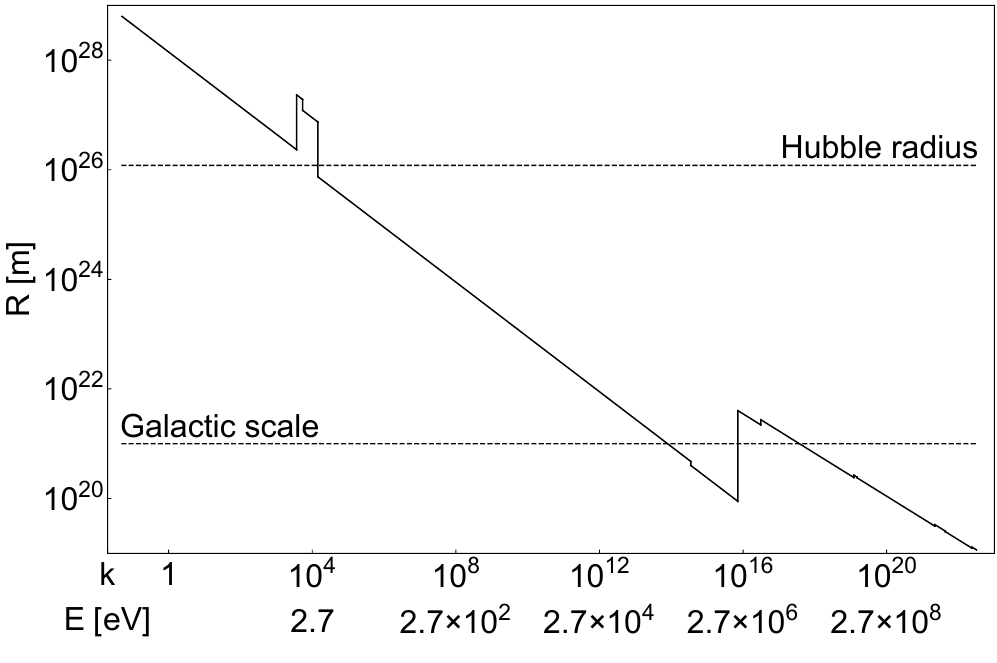
Figure 9. Maximum distance at which a single bouncing BH can be observed through its low-energy component, as a function of the k parameter, from [83] (Copyright IOP Publishing. Reproduced with permission. All rights